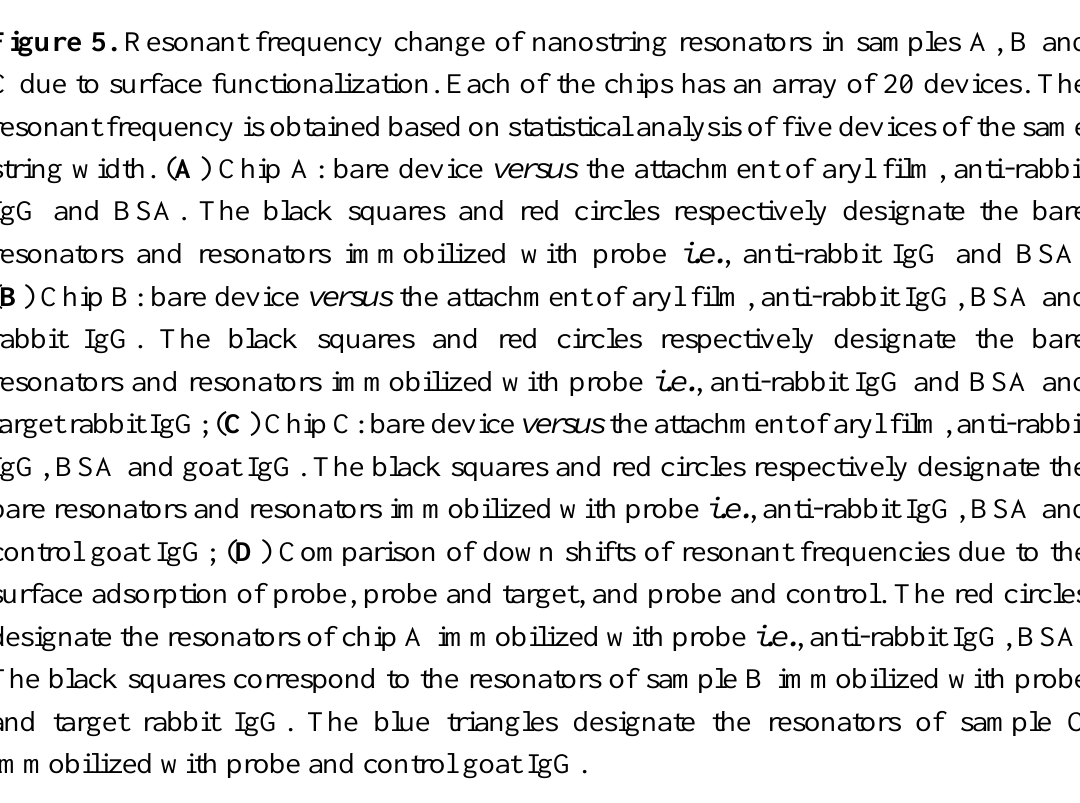
to different resonator string widths, were observed. The corresponding added mass was calculated using Equation